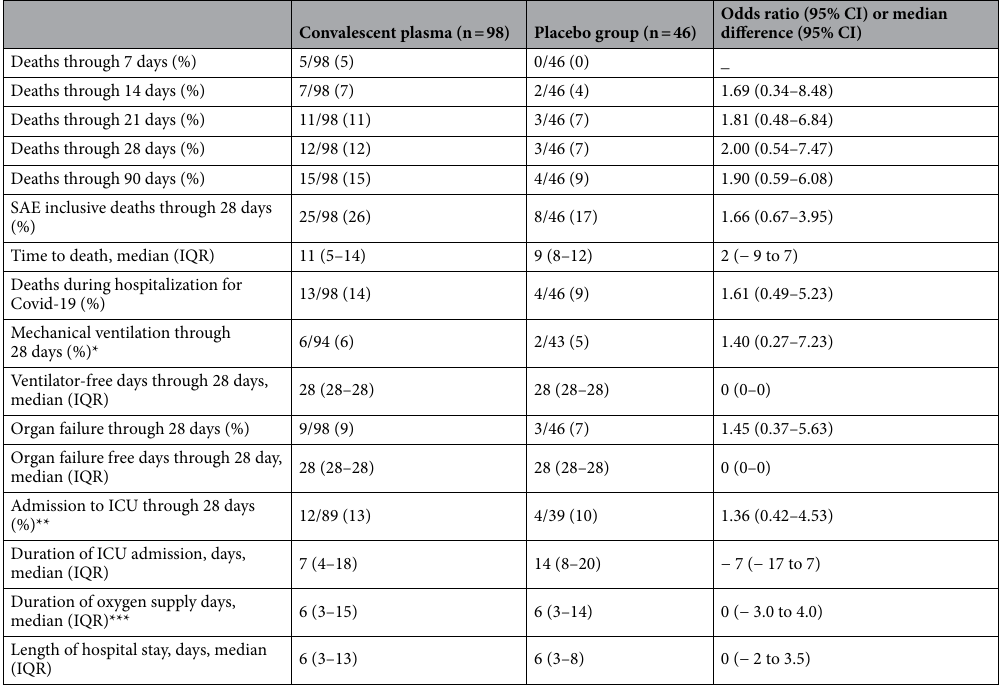
Table 3. Secondary outcomes. SAE Severe adverse events, IQR interquartile range, ICU Intensive care unit, CI confidence interval. *Patients on mechanical ventilation at randomization not included. **Patients admitted to the ICU at randomization not included. ***Patients not requiring oxygen supply not